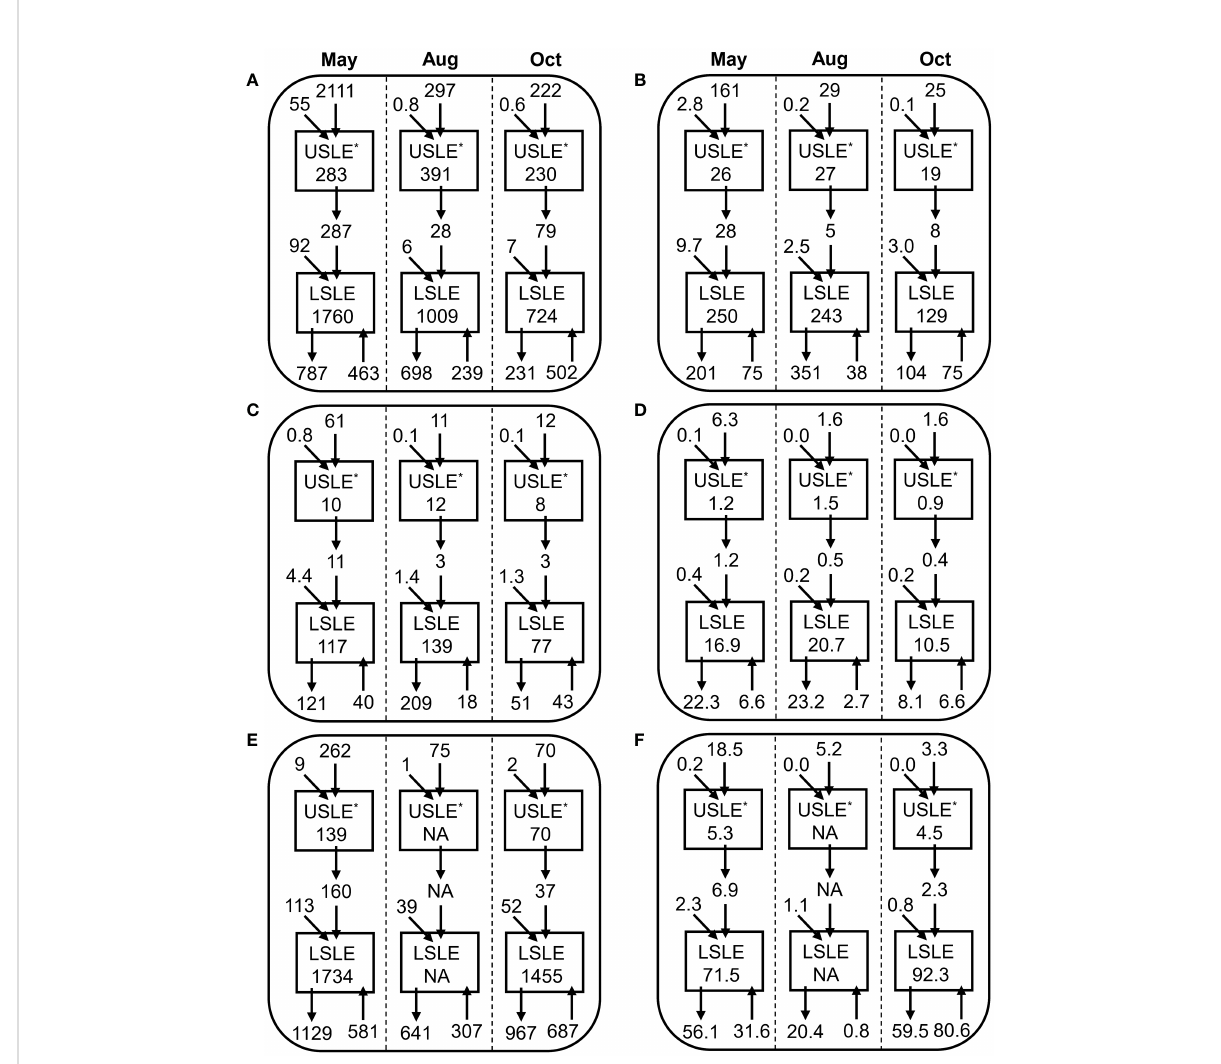
FIGURE 4 Transport (Gg) of (A) TSM, (B) POM, (C) POC, (D) PON, (E) DOC, and (F) DON by tributaries and Gulf and inventories of the USLE and LSLE for May, August and October. Arrows represent transport and inventories are inside boxes. For each month and each variable, values are presented along the upstream – downstream continuum from top to bottom, namely: SLR transport to USLE (down arrow), north+south USLE tributaries transport to USLE (tilted arrow), USLE inventory (box), transport from the USLE to LSLE (double down arrow), Saguenay + north + south LSLE tributaries transport to LSLE (tilted arrow), LSLE inventory (box), transport from the LSLE to the Gulf (down arrow), and transport from the Gulf to the LSLE (up arrow). *USLE without the